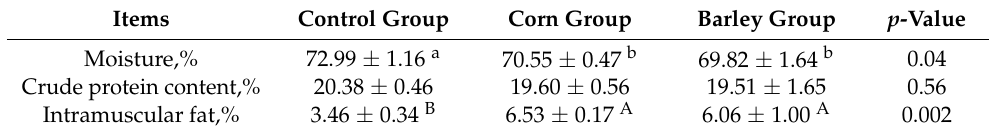
Table 5. Effects of different carbohydrate source diets on main conventional nutrients in beef (g/100 g).